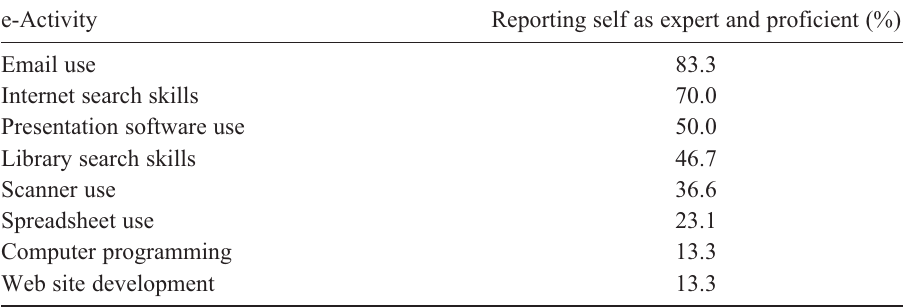
Table 2. Computer